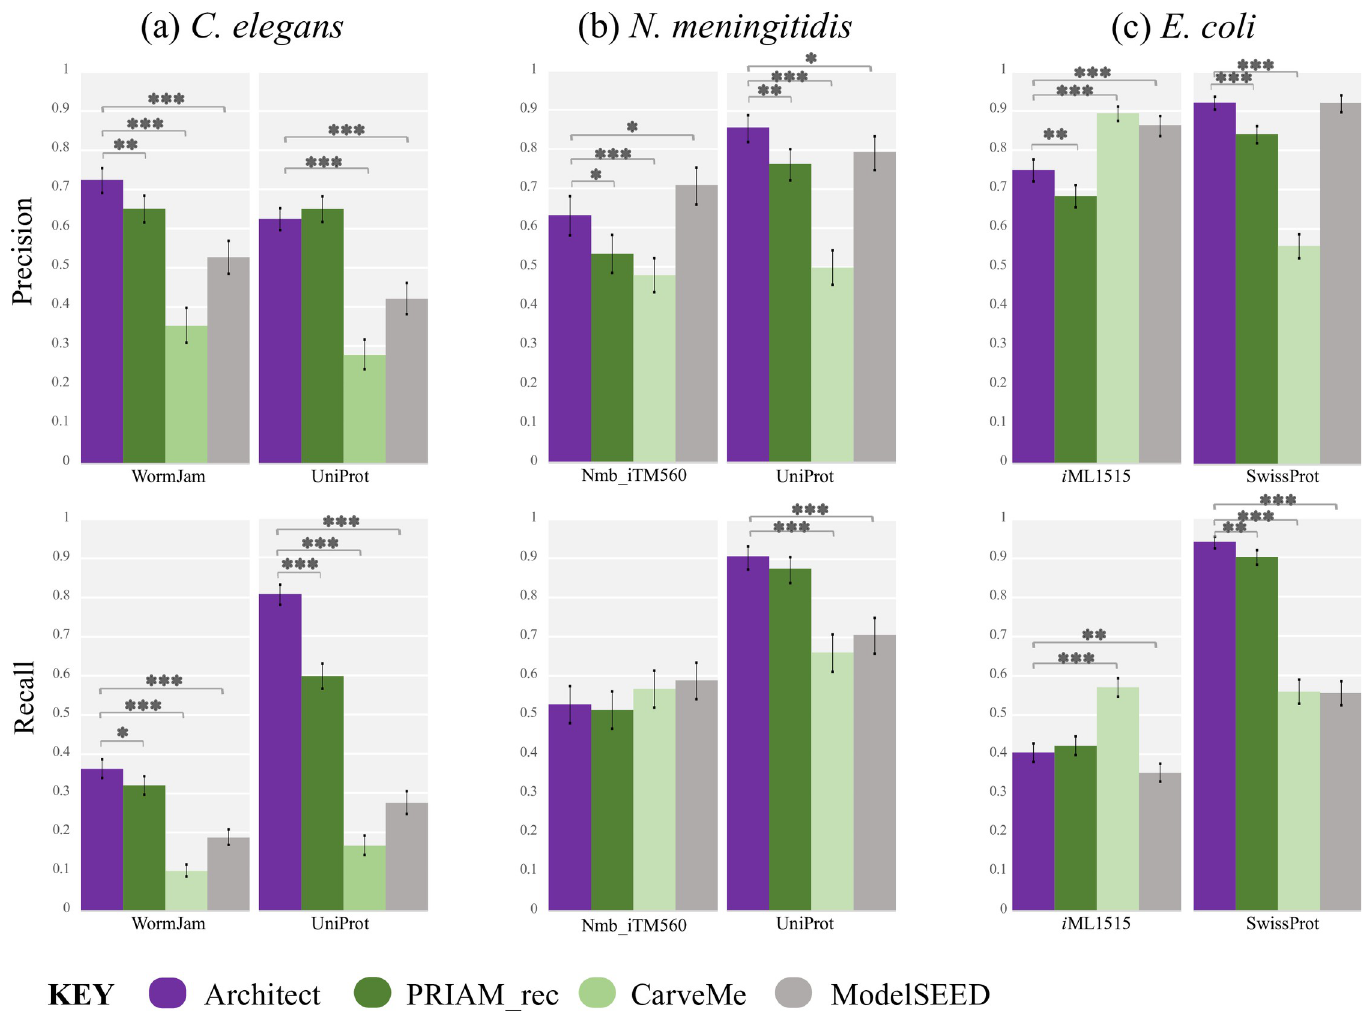
Fig 3. Performance of Architect as a model reconstruction tool versus CarveMe and PRIAM (as a model reconstruction tool). Quality of annotations is computed against the curated models over the genes found in these models, and against UniProt/SwissProt when restricting to those sequences found in the database and with ECs present in the KEGG reaction database. SwissProt was used for E . coli as the sequences were all present in the curated database. Error bars show the 95% confidence interval for precision and recall, each considered as the estimate of a binomial parameter. P-values, computed using Fisher’s exact test, are calculated only between Architect and either CarveMe or PRIAM (with � , �� and ��� representing p less than 0.05, 0.005 and 0.0005